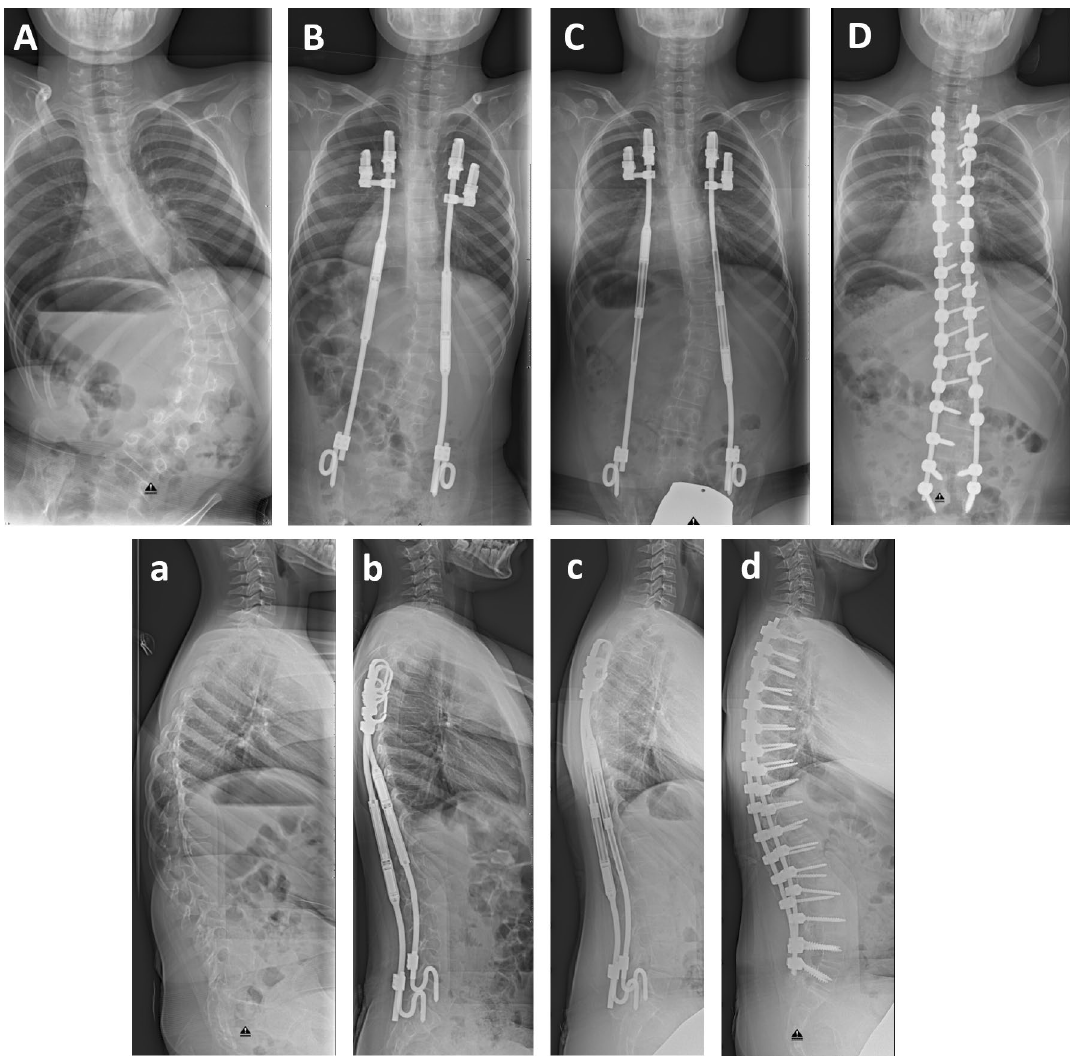
result could be maintained within the four-year follow-up ( C ) and after spondylodesis ( D ). The sagittal profile could be improved. Initial kyphosis of 42° (a) could be corrected to 29° directly after surgery (b) and to 36° during follow-up (c) and spondylodesis (35°,